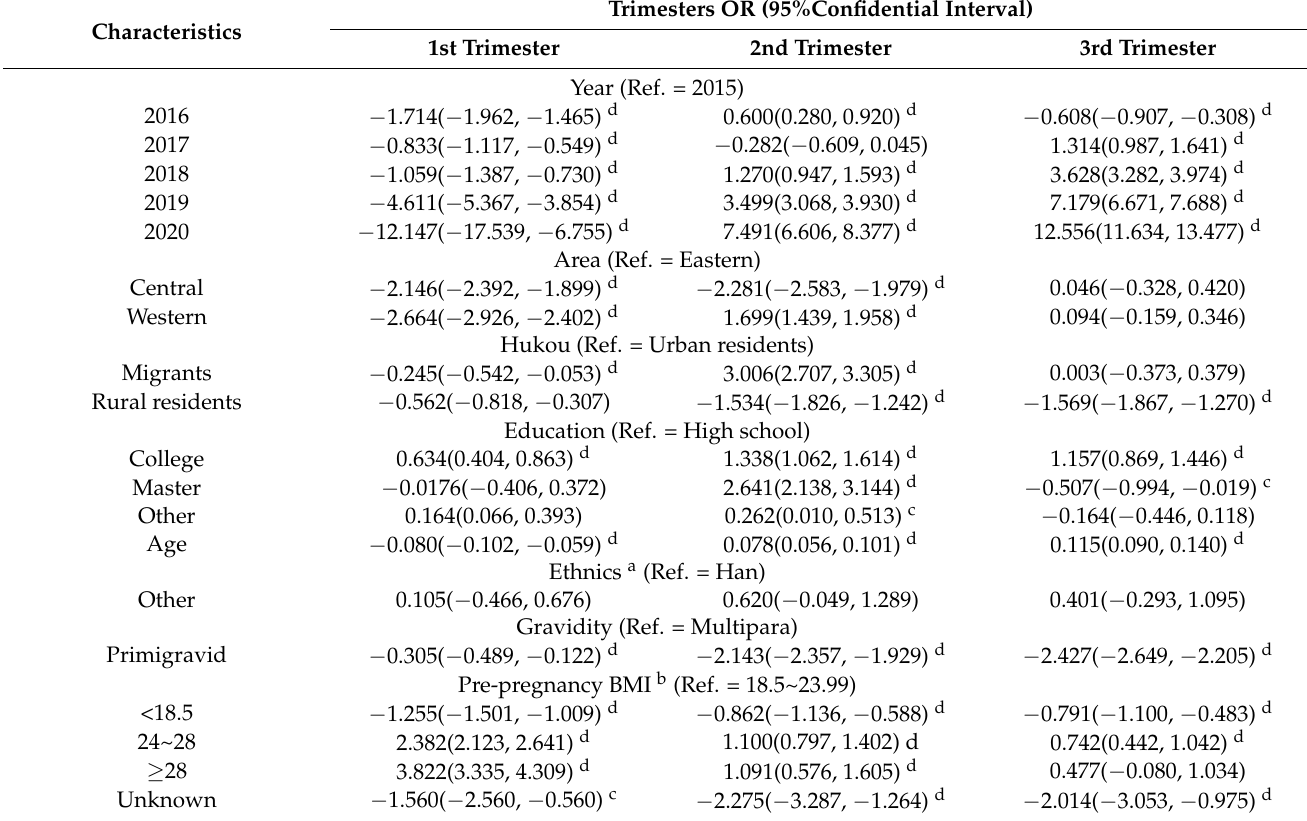
Table 6. Associations between basic characteristics and hemoglobin concentrations (g/L) in pregnant women according to